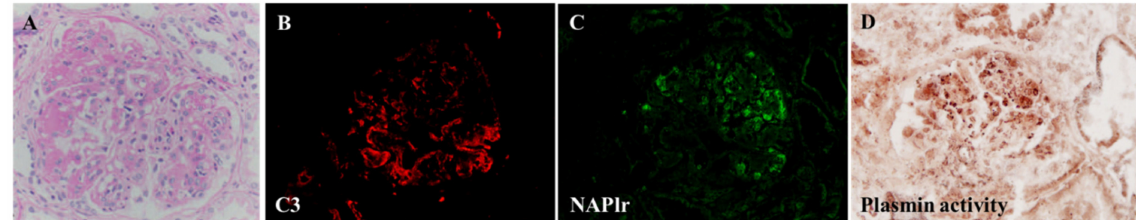
Figure 21. Kidney biopsy findings for case 5 in Table 8. ( A ) Light microscopy showing diffuse proliferative and exudative glomerulonephritis with infiltrating neutrophils (periodic acid–Schiff, original magnification × 400). ( B , C ) C3 ( B ) and NAPlr ( C ) were both positive in glomeruli, and their localization was essentially different ( B , C ). ( D ) In situ zymography showed that the plasmin activity was similar to the NAPlr staining in the glomeruli in its distribution. Photographs are cited from a previously published report [89], where details of all the staining methods have been described.